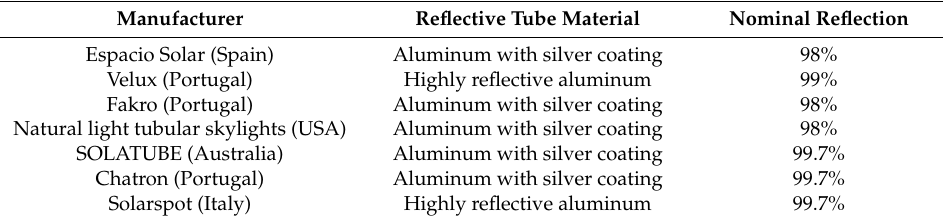
Table 1. Commercial Reflective Tubes.